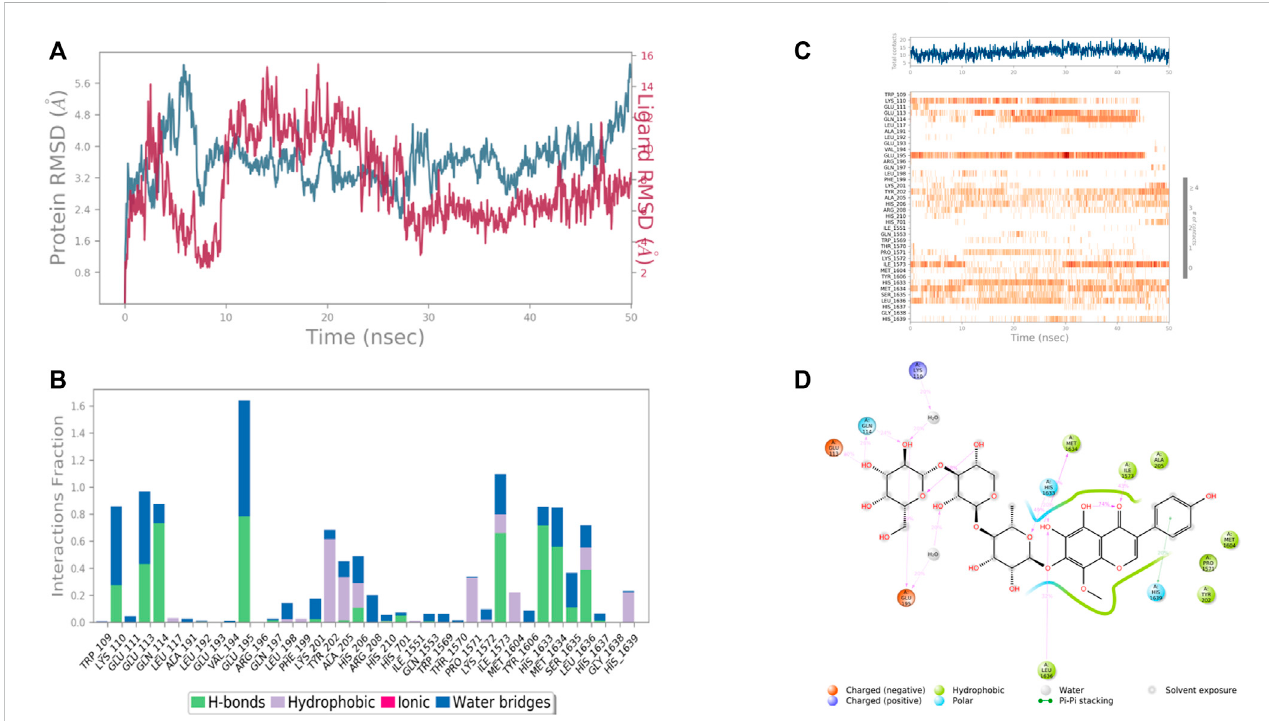
FIGURE 13 RMSD plot of the protein – ligand complex [RIMS-binding protein 3A (Gene: RIMBP3) (AlphaFold)) (A) , Protein-ligand contacts (B) , stacked bar plot of the fraction of time of the interactions (C) and Ligand- Protein contacts (D) of analogue 4 ′ ,5,6,7-Tetrahydroxy-8-methoxyiso fl avone-7-O-beta-D-